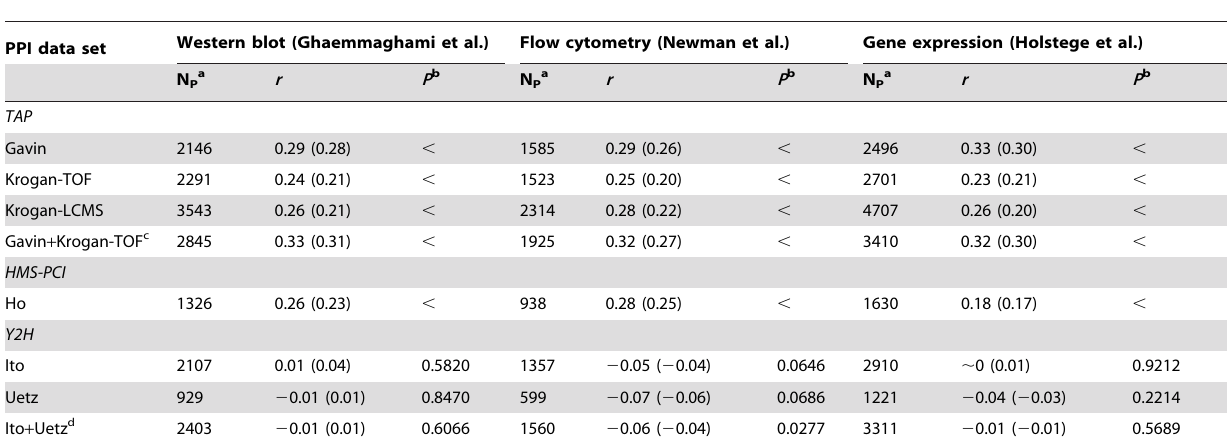
Table 1. Pearson correlation coefficients ( r ) and corresponding P -values for tests of linear association between log(degree) and log 2 (abundance) in raw yeast PPI data sets.